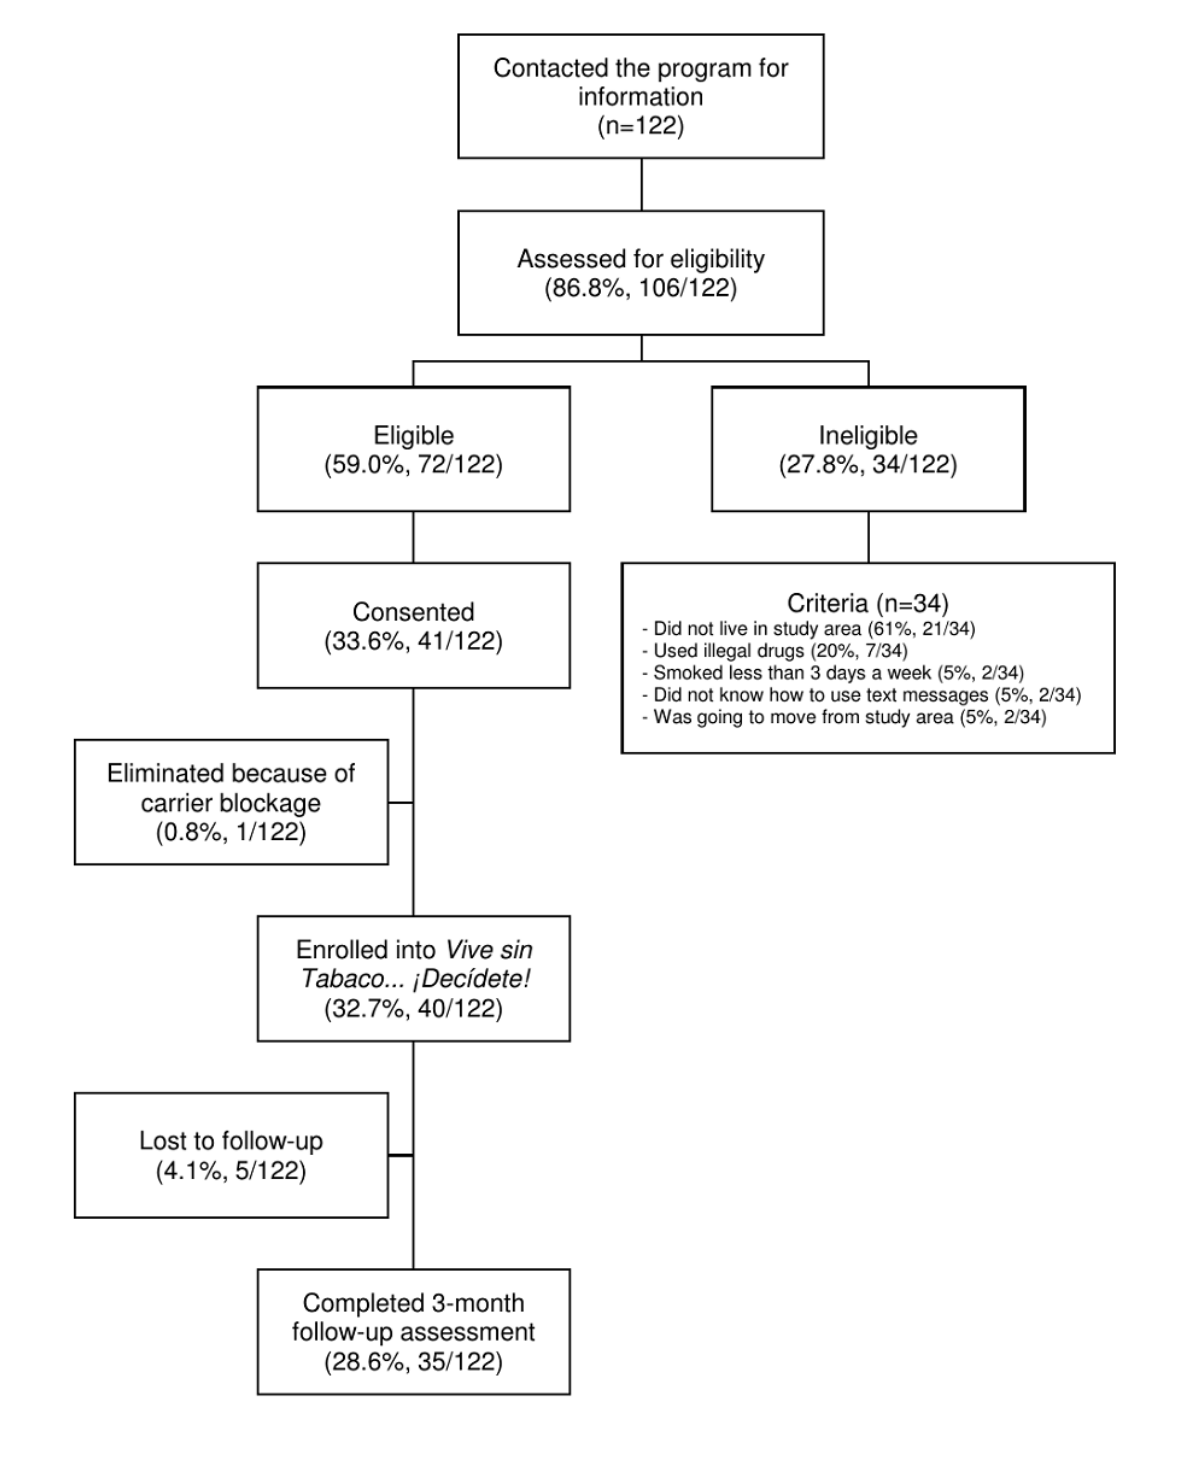
Figure 1. Vive Sin Tabaco… ¡Decídete! intervention